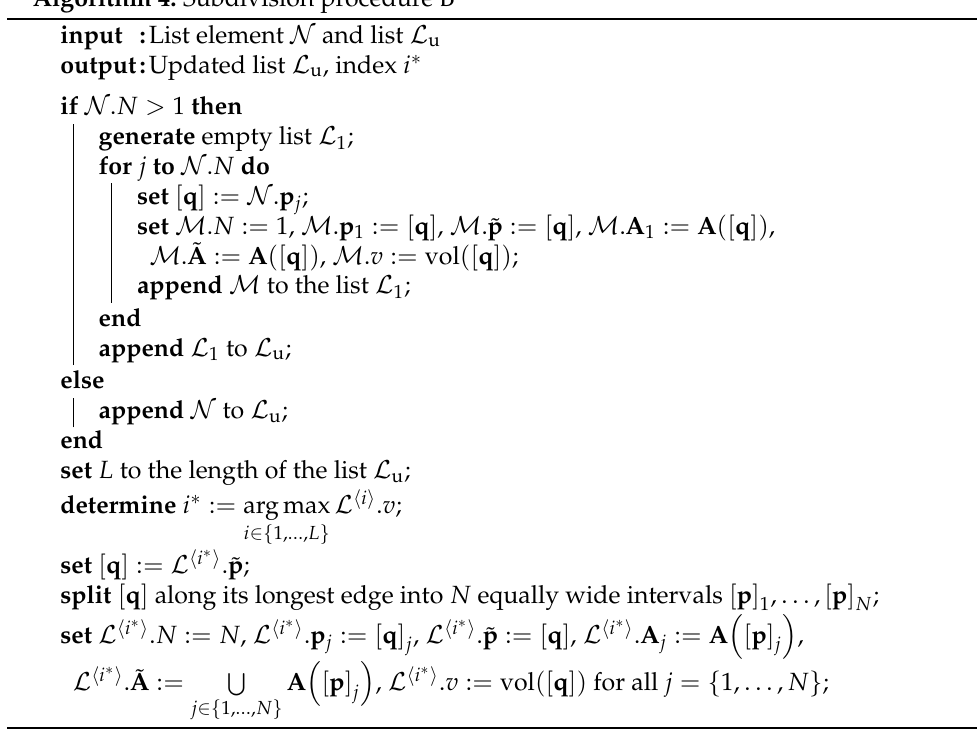
Algorithm 4: Subdivision procedure